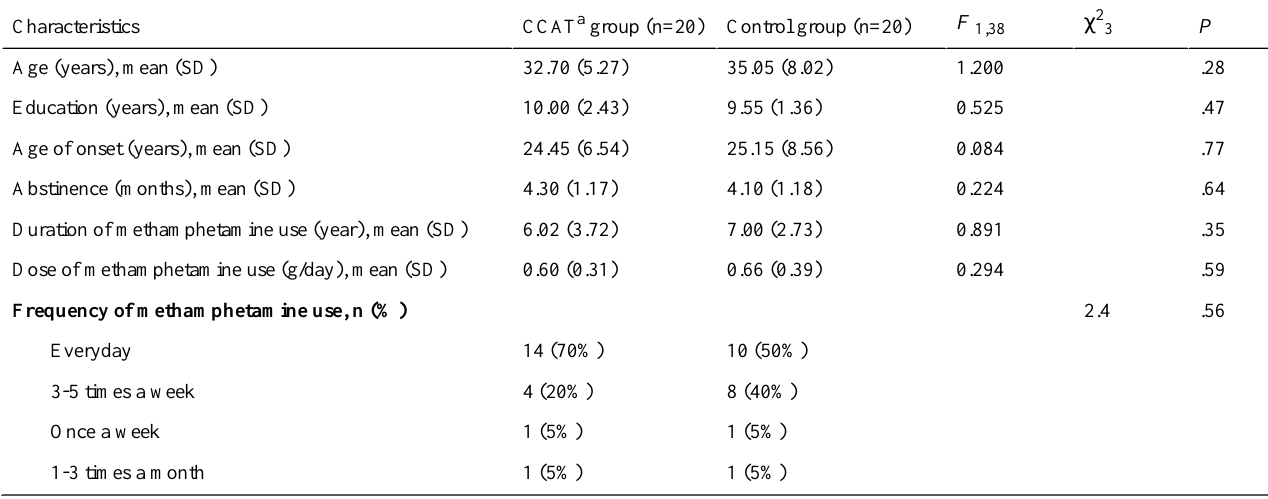
Table 1. Demographic and drug use characteristics of participants